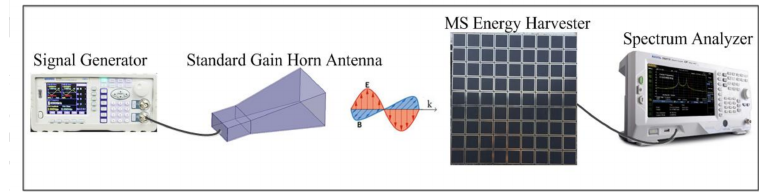
Figure 10. Experimental setup for measuring the power harvesting efficiency of MS